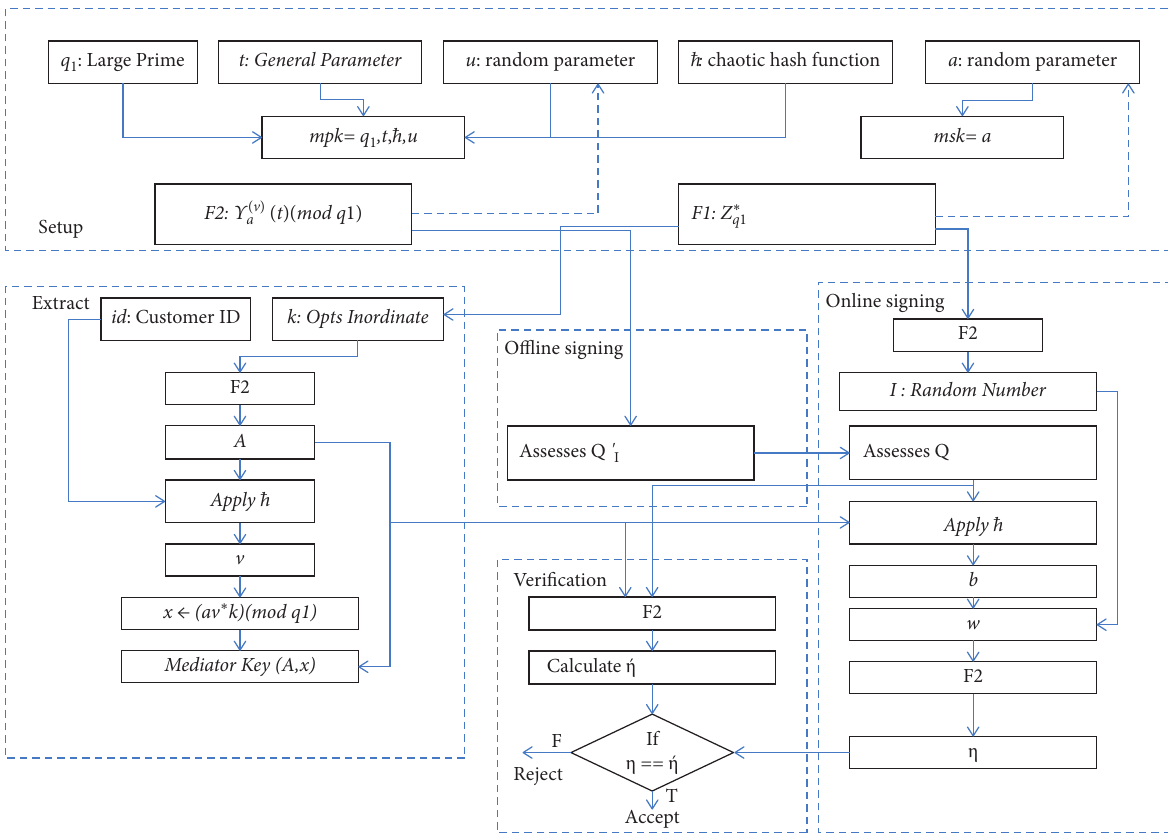
Figure 2: Block diagram of the proposed